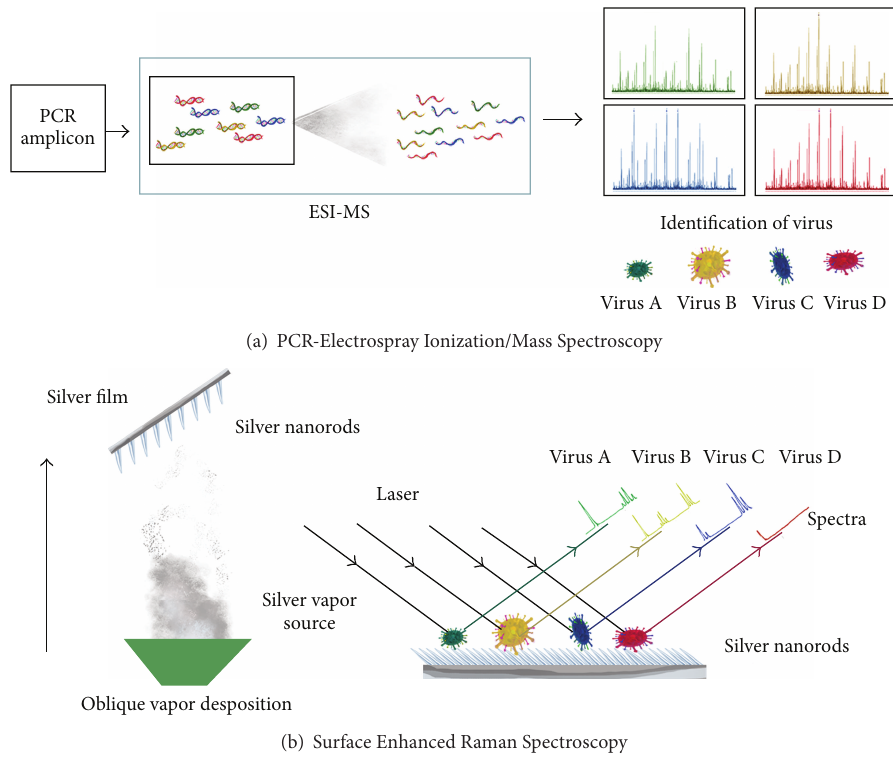
Figure 3: A schematic representation of biophysical method of RSV detection. (a) PCR-electrospray ionization mass spectroscopy and (b) Surface enhanced Raman